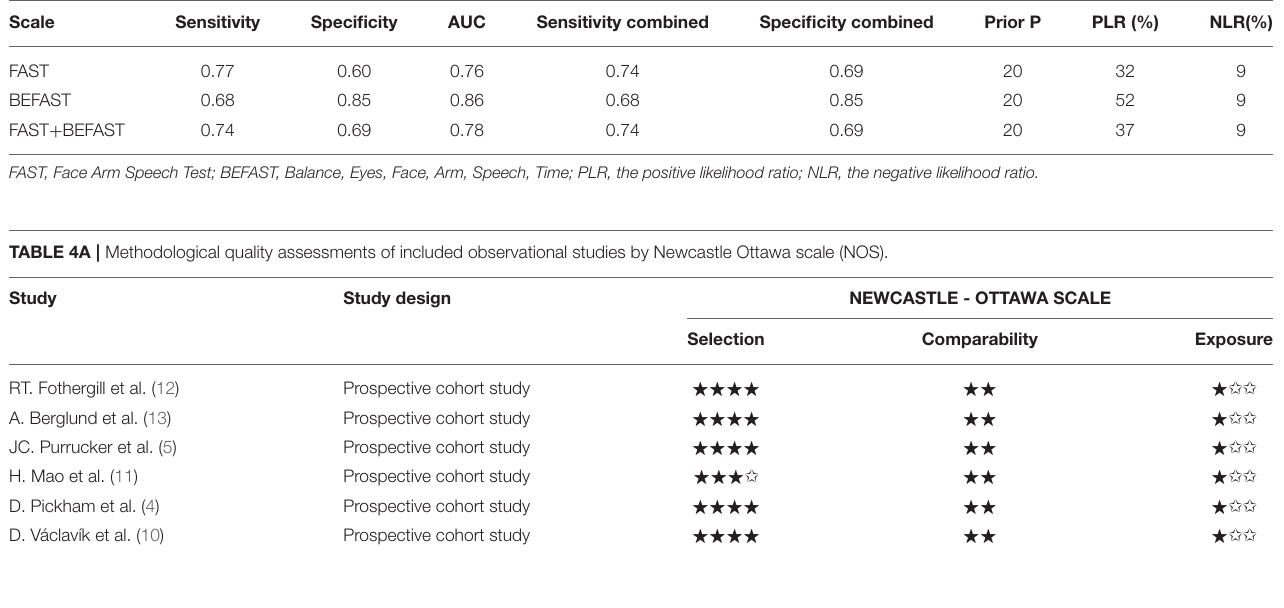
TABLE 3 | Diagnostic performance of FAST, BEFAST, and FAST in combination with BEFAST.